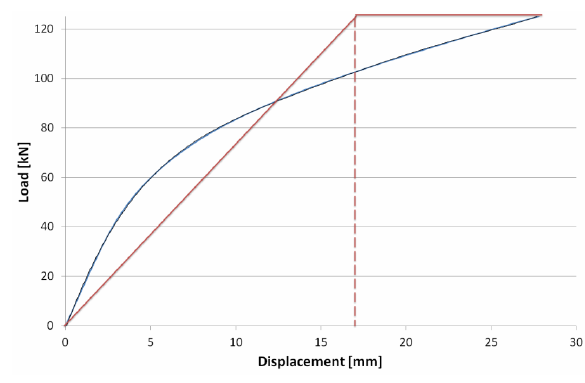
Figure 16. Determination of the idealized elasto- perfectly plastic force – displacement relationship for the frame with rigid